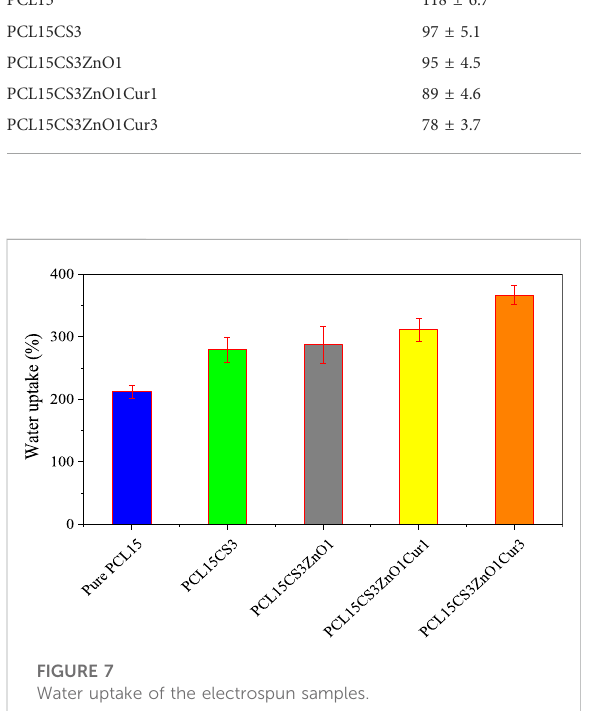
FIGURE 7 Water uptake of the electrospun samples.